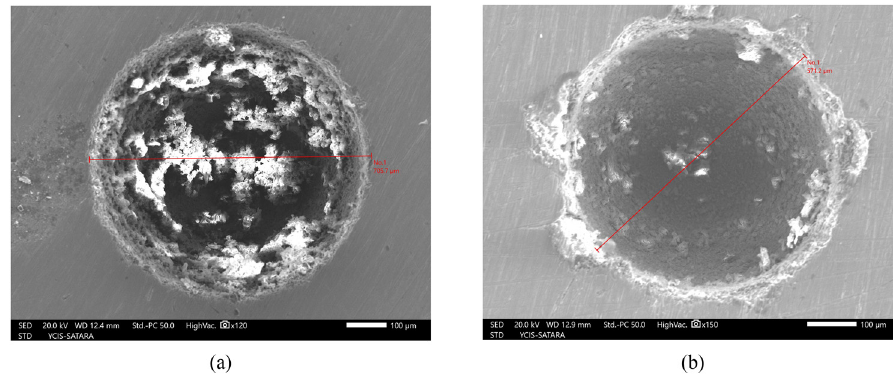
Figure 8: SEM × 100 of machining hole. ( a ) Exp. No. 9 ( the worst optimal e ff ect ) and ( b ) Exp. No. 1 ( the best optimal e ff ect ) .